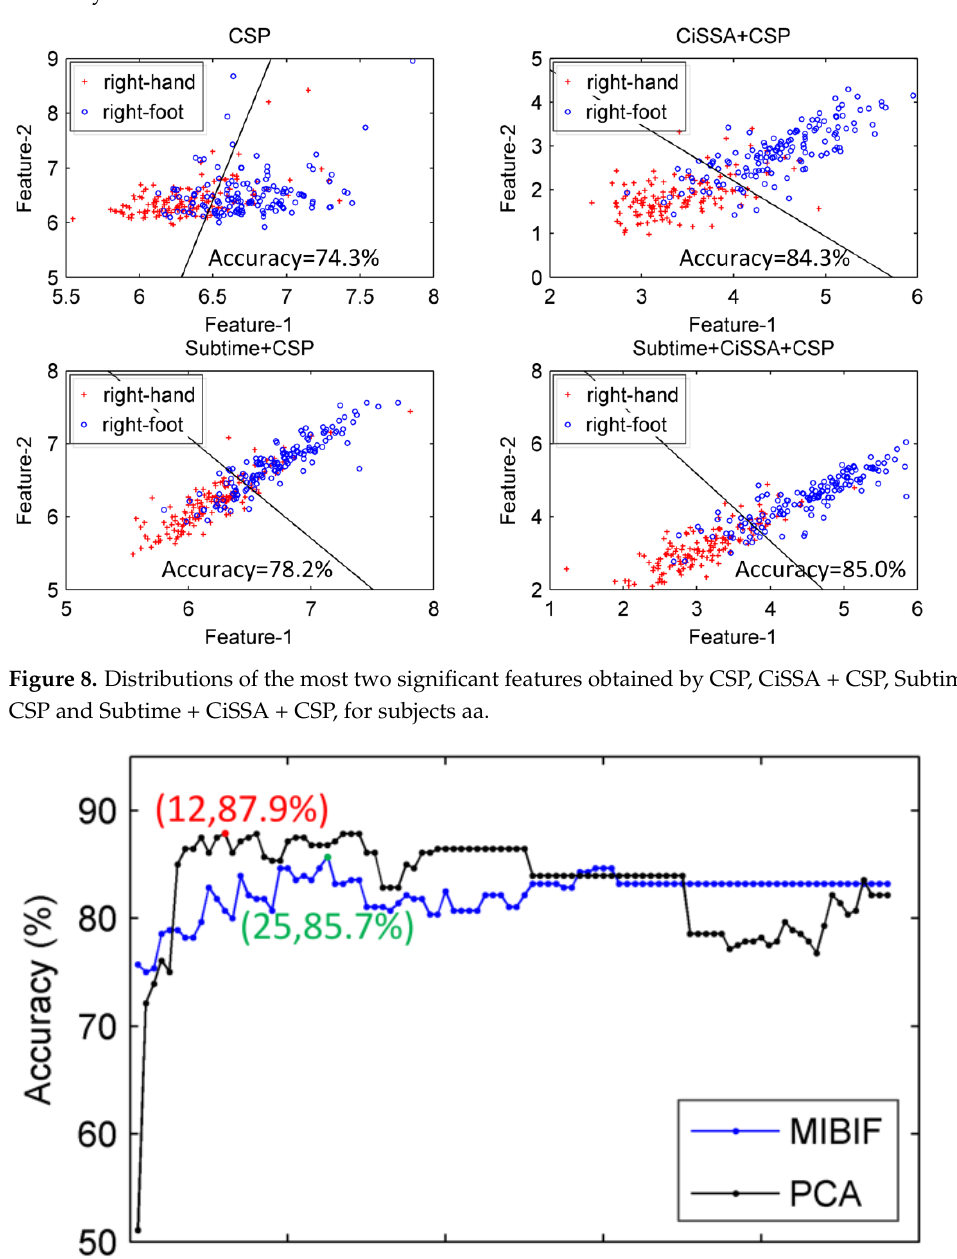
Figure 9. Classification accuracy over the number of selected features by MIBIF and PCA for subjects av.